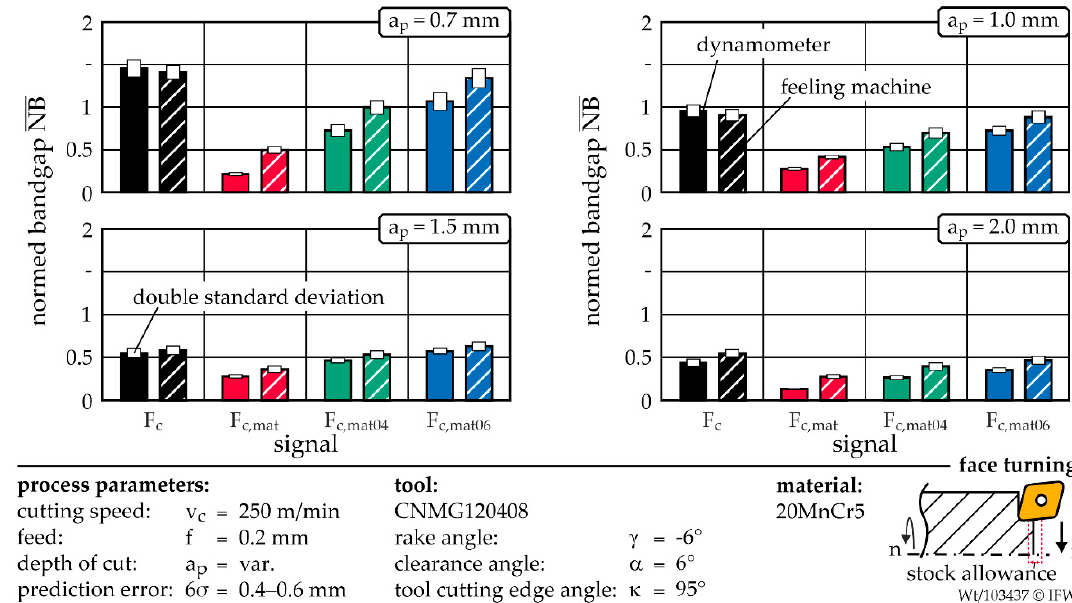
Figure 8. Comparison of the normed bandgaps for different initial depths of cut for stock allowance variation A, deviation of the predicted geometry A and the different prediction error ranges by using a dynamometer or the feeling machine.